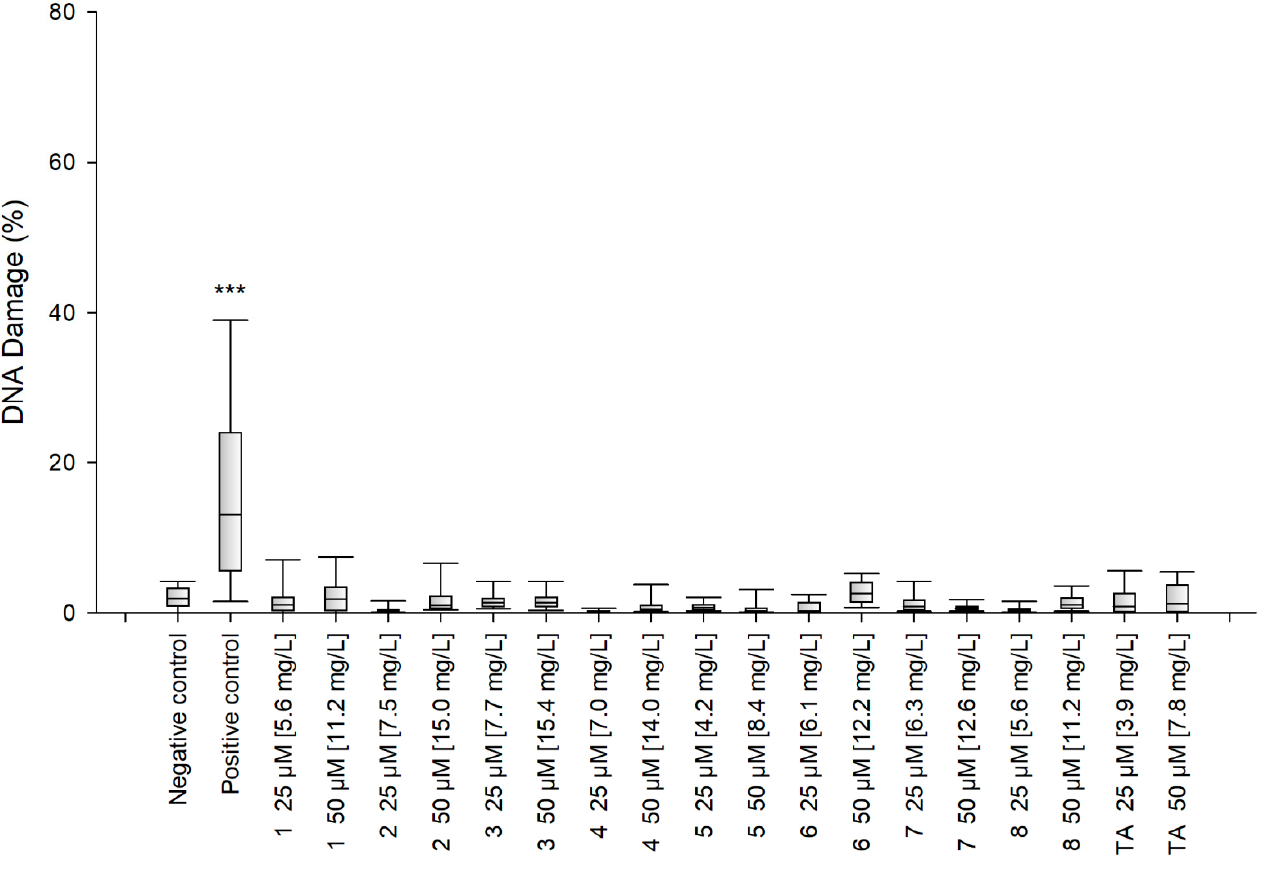
Figure 13. Genotoxicity of the tested compounds. Statistical analysis was based on the results of three independent tests. The differences were statistically significant as follows: *** p < 0.001 versus the negative control.